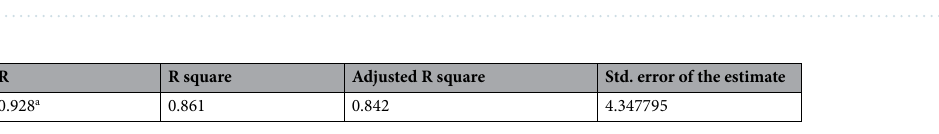
Figure 12. Chart for the standardized effects of temperature, chloride, sulfate, bisulfide, and pH, as predicted by CHAID Tree Decision with three tree depths on the corrosion current density of carbon steel in soil.